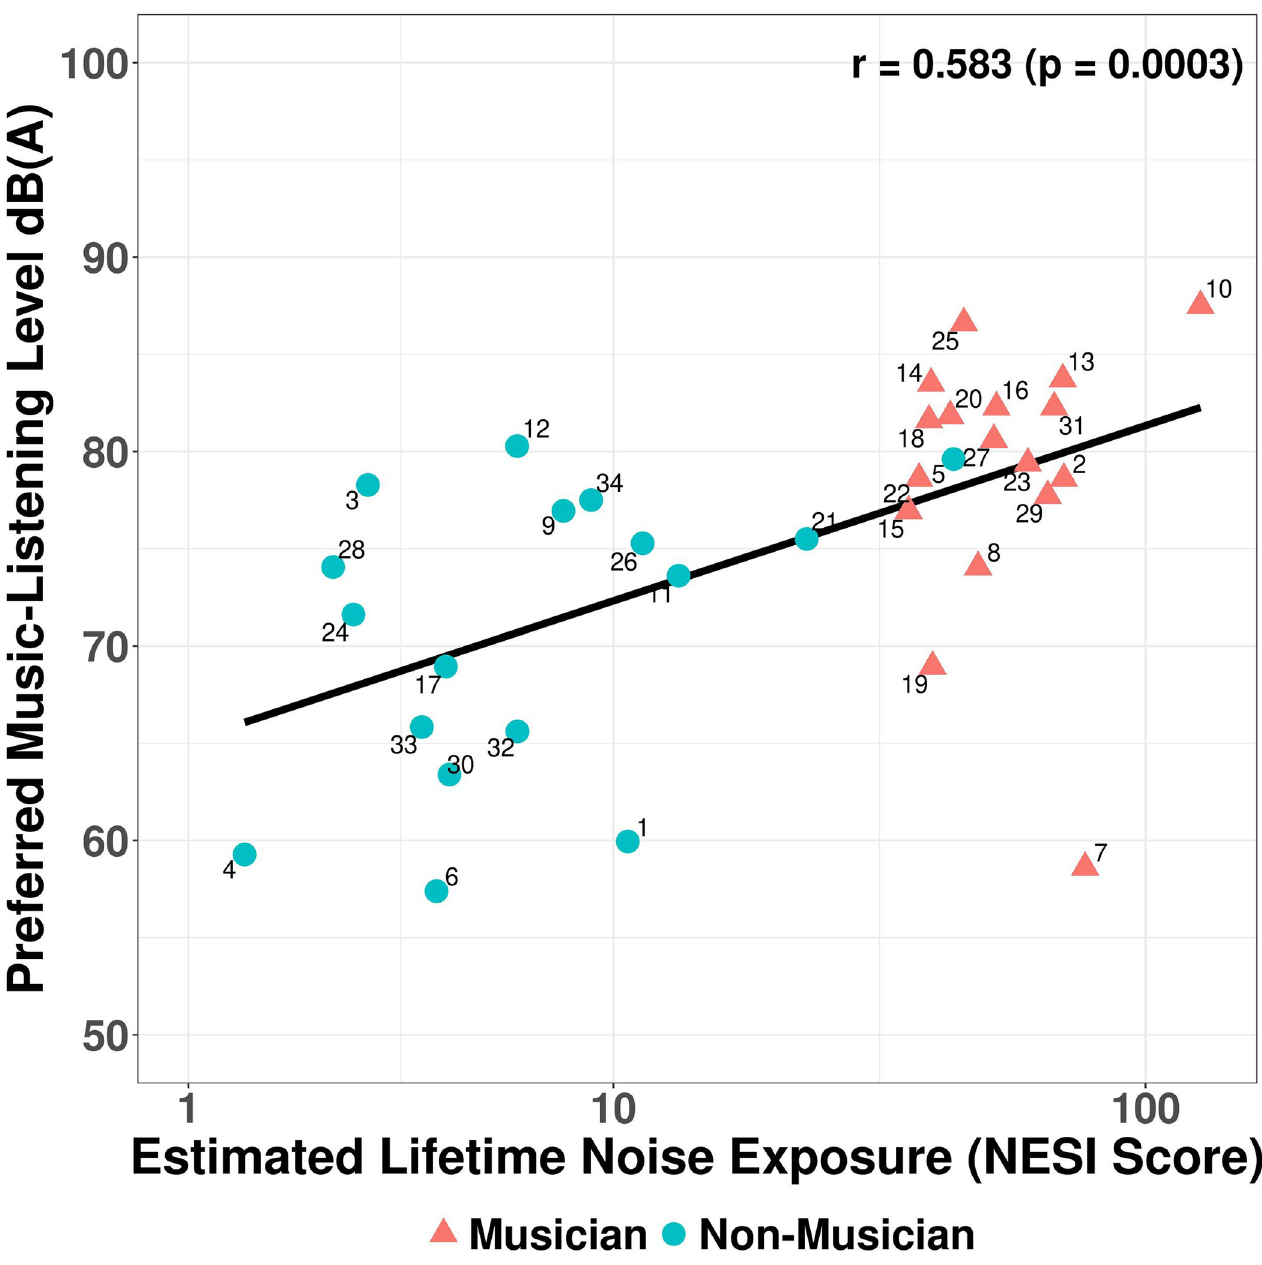
Fig 3. Preferred music-listening level as a function of lifetime noise exposure (NESI